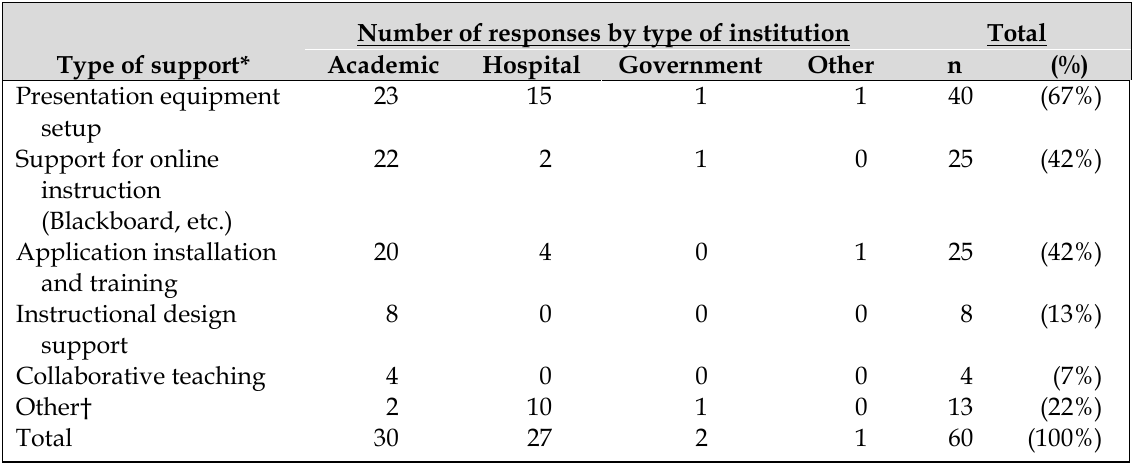
Table 1 Information technology (IT) support for